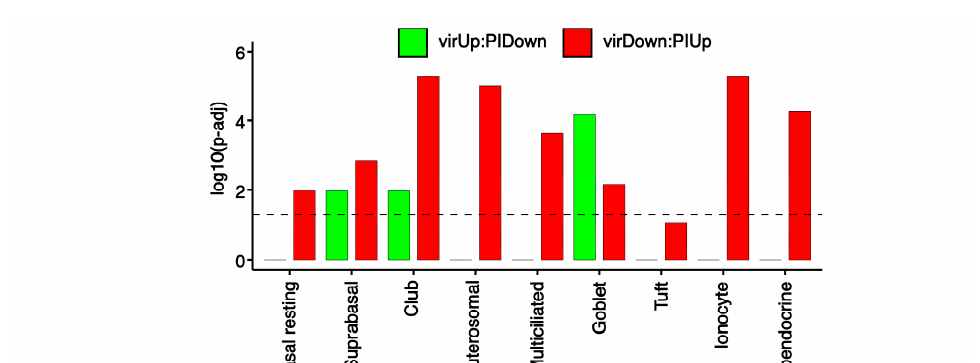
Figure 7. Pathway and cell–type enrichment analyses of RV–A16 response genes whose viral effect is opposed by PI. Barplots of enrichment scores of select IPA canonical pathways enriched for genes in the VirUp:PIDown (viral upregulated genes whose effect is opposed by PI) gene set ( A ) and VirDown:PIUp (viral downregulated genes whose effect is opposed by PI) gene set ( B ). Enrichment scores are represented as -log10 of Benjamini–Hochberg (BH) adjusted p -values obtained from IPA. ( C ). Cell diagram of the IPA interferon signaling pathway, with node colors representing the logFC in gene expression between RV-A16 + PI and RV-A16 cultures. ( D ). Barplot of enrichment scores for airway epithelial cell-type gene signatures within VirUp:PIDown (green) and VirDown:PiUp (red) gene sets. Enrichment scores were represented as –log10 of BH–adjusted p -values obtained from the hypergeometric